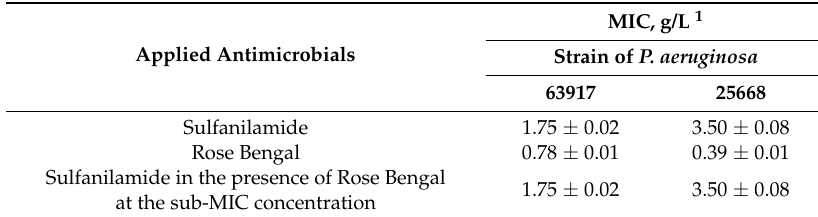
Table 2. MIC values of antibacterial agents for the P. aeruginosa antibiotic-sensitive strain 25668 and the antibiotic-resistant strain